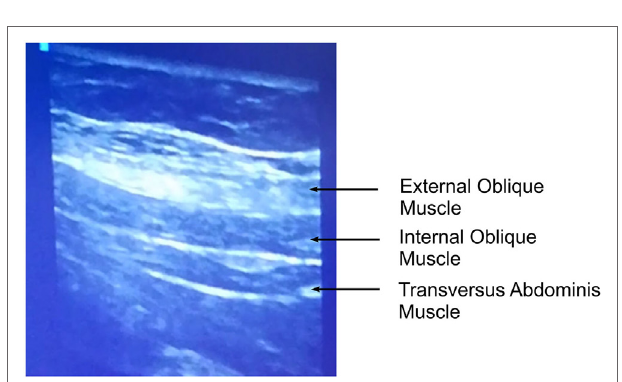
FiGURe 2 | Muscles of the anterolateral abdominal wall.